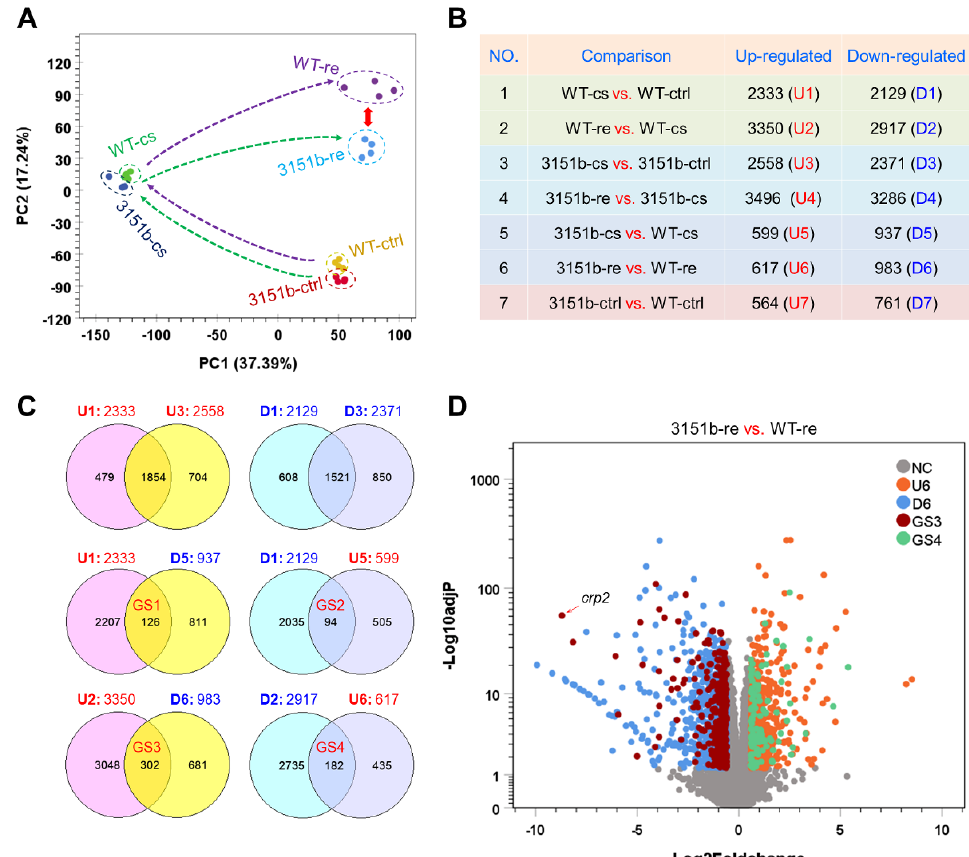
Figure 4. Effects of Tmem39b dysfunction on gene transcriptional expression of zebrafish larvae during cold exposure and rewarming. ( A ) Results of principal component analysis (PCA) illustrate the overall change in gene expression between different treatments and fish lines. The dashed arrows show the trajectory of gene expression alteration during cold exposure and rewarming. The red double ‐ headed arrow demonstrates the augmented distance between the WT and zko3151b mutants during the recovery phase. ( B ) Numbers of the genes differentially expressed between different treatments and fish lines. The up ‐ and down ‐ regulated gene sets (U and D) are numbered sequentially according to the comparisons. ( C ) Venn diagrams demonstrate the number of genes affected by tmem39b mutation under different circumstances. ( D ) A volcano plot indicates the genes affected by Tmem39b deficiency during rewarming. Representative genes induced by rewarming and negatively affected by tmem39b mutation are shown. NC, not changed; U6 and D6, the same as in ( B ); GS3 and GS4, the same as in ( C ).